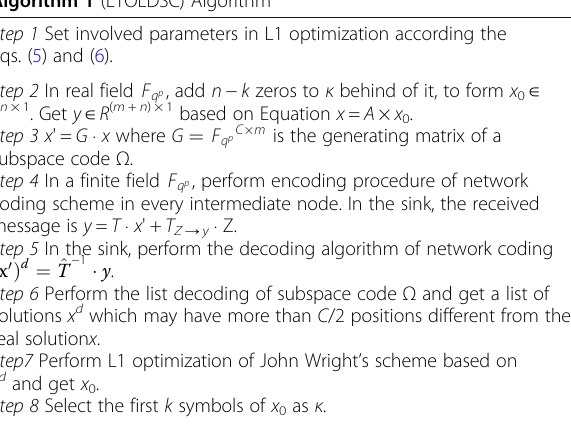
Algorithm 1 (L1OLDSC)